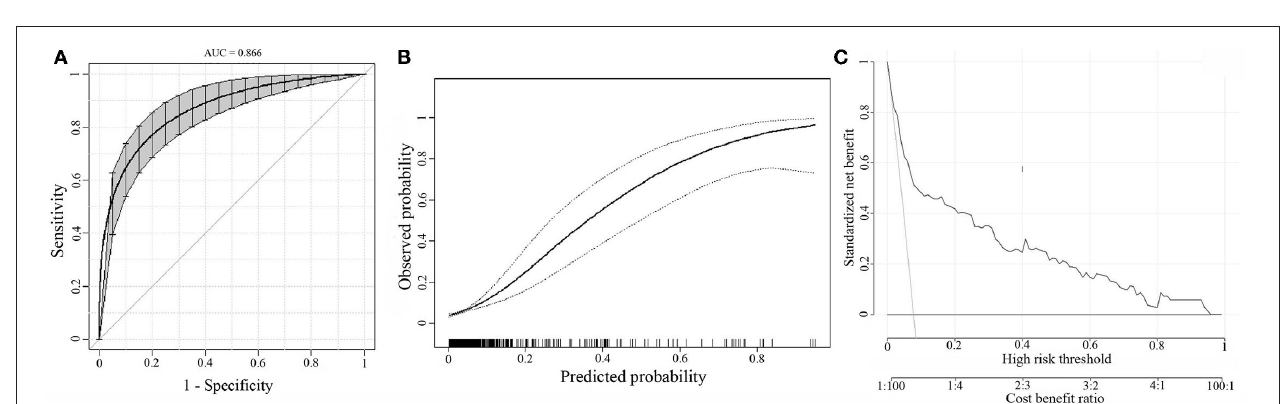
FIGURE 3 | Internal model validation. (A) The discrimination of the prediction model by the bootstrap method. (B) Calibration plots of the model by the bootstrap method. (C) Decision curve analysis for the model.